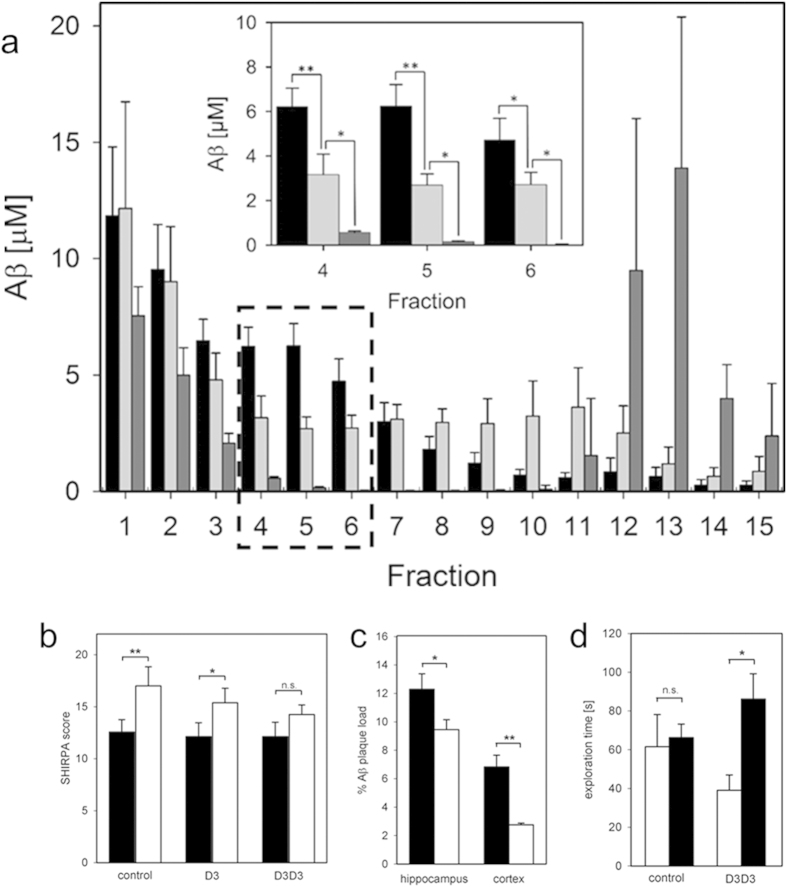
Effects of D3 and D3D3 in vitro and in vivo.(a) QIAD assay. After pre-incubation of 80 μM Aβ(1–42) for 4.5 h at RT and further incubation for 40 min at RT with or without agent, Aβ(1–42) size distributions in the absence (black) or presence of either D3 (light gray, 32 μg/ml, 20 μM) or D3D3 (dark gray, 32 μg/ml, 10 μM) were analyzed by DGC. Aβ(1–42) concentrations as determined by UV absorption during RP-HPLC are shown with standard deviations. Aβ(1–42) oligomers of interest (dashed box) are located in fractions 4 to 6. (Inset) Magnification of boxed area displaying significant differences of Aβ(1–42) oligomer contents between untreated (black), D3 treated (light grey) and D3D3 treated Aβ(1–42) (dark grey). Paired U-test; *p ≤ 0.05, **p ≤ 0.01 (b) Assessment of TBA 2.1 phenotype using part of the SHIRPA test battery before (black) and after i.p. treatment (white) for 4 weeks with phosphate buffered saline (n = 7), or D3 (n = 8) or D3D3 (n = 8) (5.1 ± 0.1 mg per kg body weight per day). Repeated measures ANOVA before vs. after p = 0.0027, paired t-test (hypothesized difference ≥0) before vs. after, *p = 0.035, **p = 0.010. (c) Plaque load reduction of D3D3 treated Tg-SwDI mice (n = 10) (white) as compared to saline-treated controls (n = 9) (black) in hippocampus and cortex. Unpaired t-test (hypothesized difference ≥0) D3D3 vs. saline, *p = 0.020, **p < 0.0001. (d) Object recognition test of Tg-SwDI mice treated either with D3D3 or saline (control). Preference for the new object (black) is expressed as exploration time in comparison with exploration of a familiar object (white); Paired t-test (hypothesized difference ≥0) before vs. after, **p = 0.016. n.s.: not significant (p > 0.05).